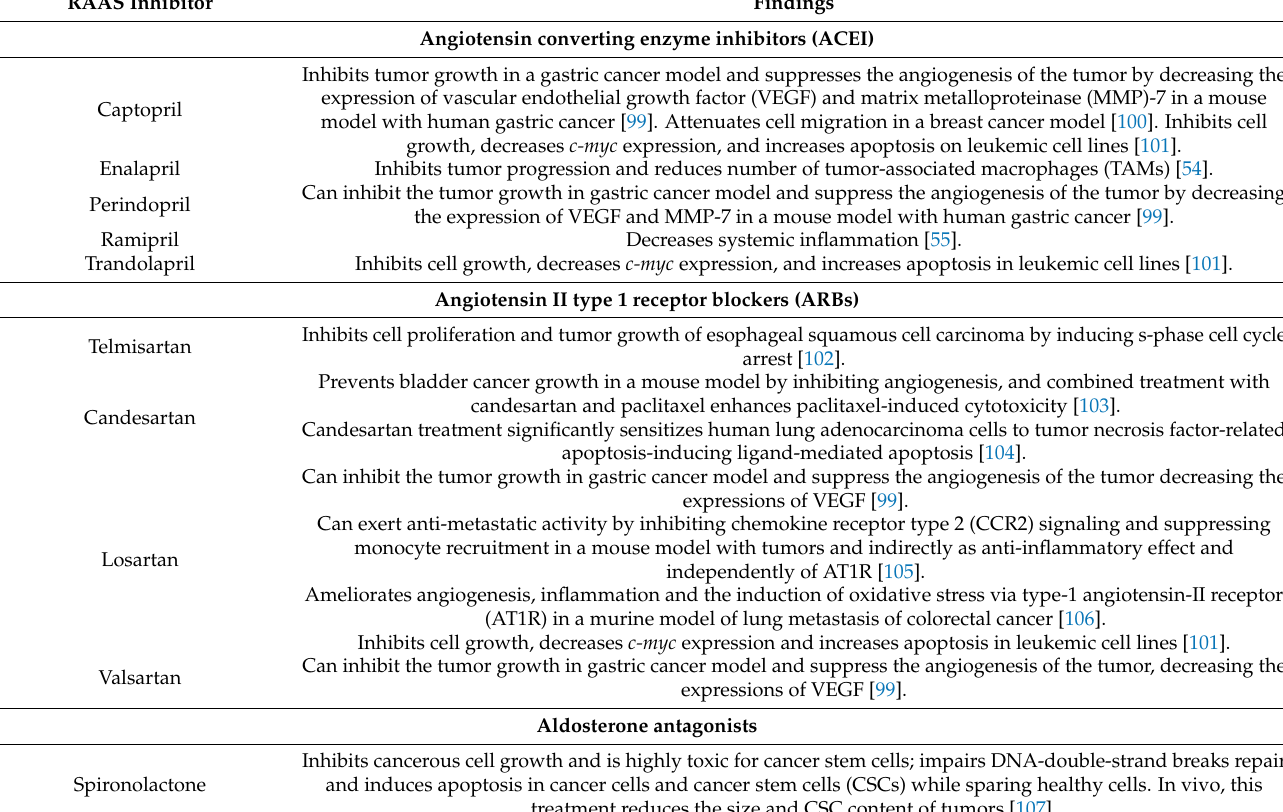
Table 3. Role of RAAs inhibitor in cancer preclinical